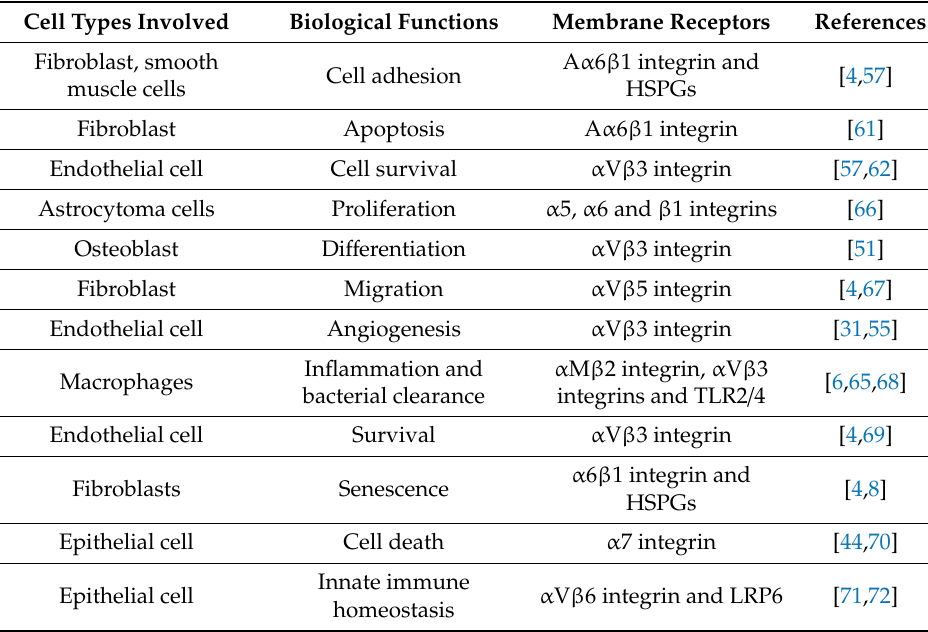
Table 2. CCN1 biological functions and